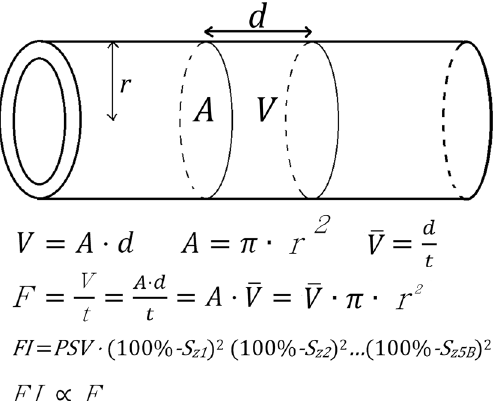
Figure 3. Derivation of volumetric flow rate and the FI. Volumetric flow rate is the volume infused per unit of time; volume is the product of area multiplied by distance. The formula can be expressed as F = where A is the area, d is the distance, F is the volumetric flow rate, t is the time, and V is the volume. Area is · the product of π radius 2 ; velocity is the quotient of distance divided by the time. The formula can be further V = A · d = A · V = V · π · r 2 , where π is the circular constant, r is the radius, and V is the expressed as F = t t velocity. The radius can be expressed as 100%-stenosis% measured by CTA; velocity can be expressed as PSV measured by DUS. Thus, we used the FI as to replace volumetric flow rate in measuring arterial